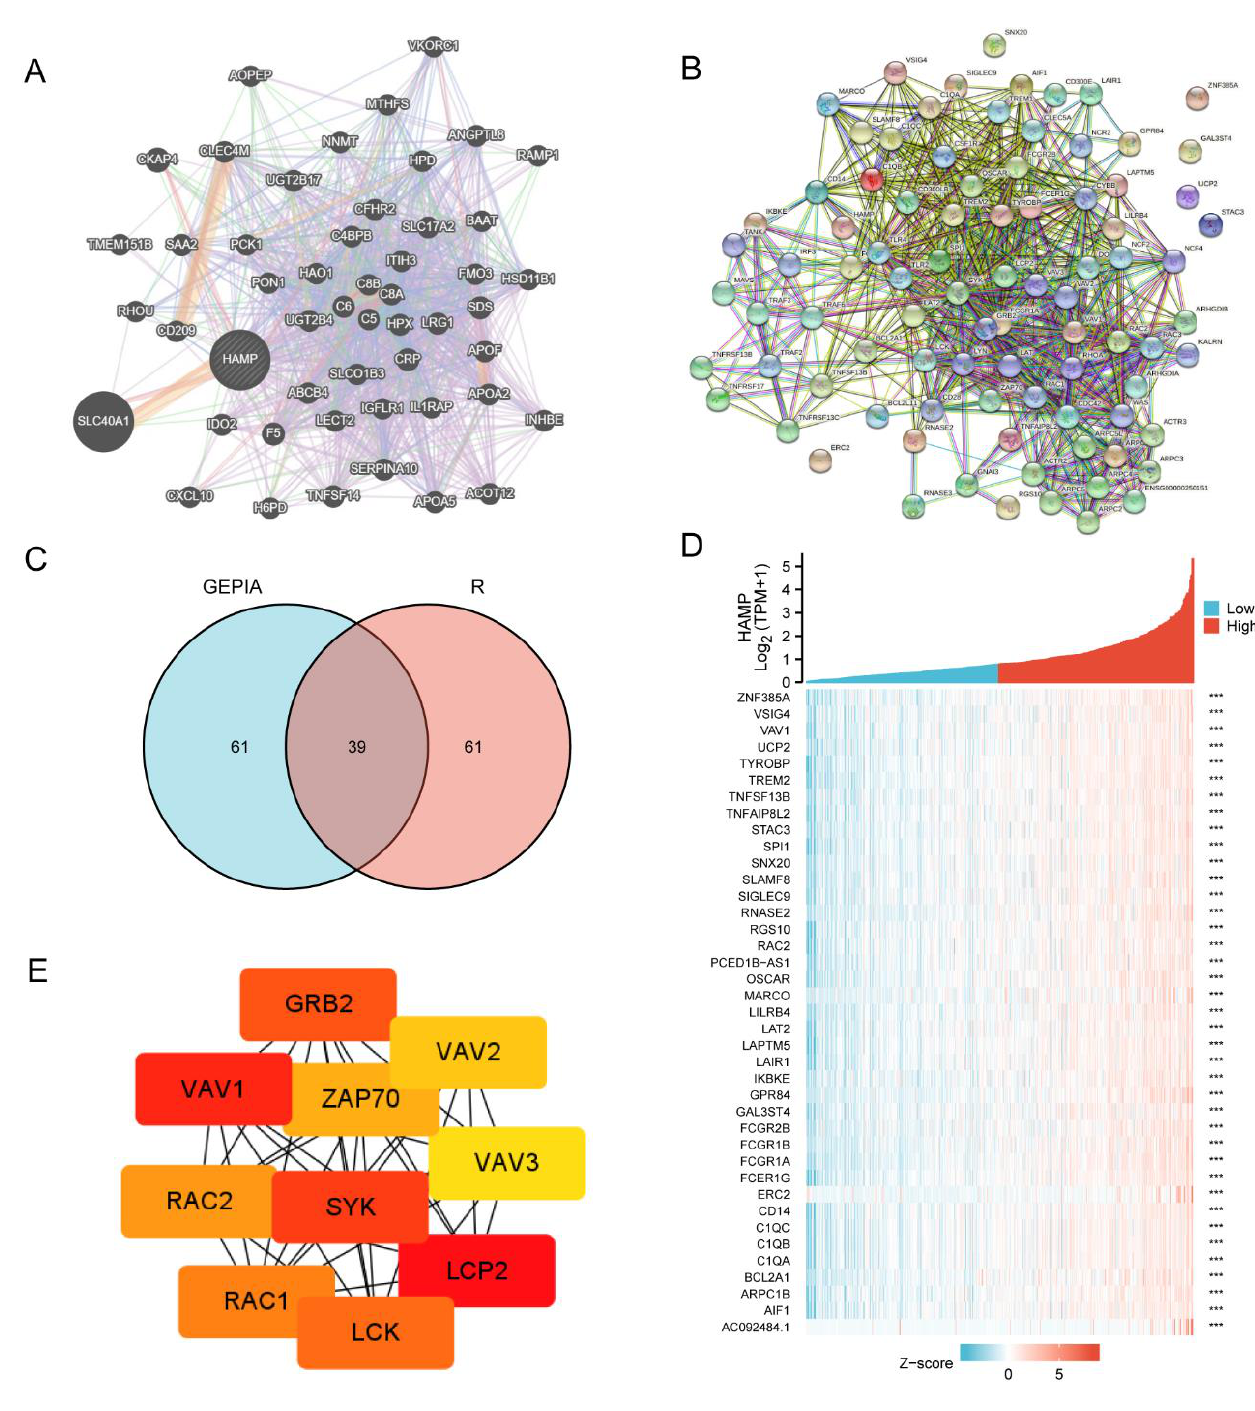
Figure 5. The PPI network and related genes of HAMP in KIRC. ( A , B ) The PPI networks of HAMP constructed by GeneMANIA and STRING. ( C , D ) The intersections of 39 co-expressed genes re- vealed by GEPIA and R programming, and their trends compared with the expression of HAMP. ( E ) Top 10 hub genes in HAMP expression selected by cytoHubba, based on the PPI and co-expression networks (*** p < 0.005).